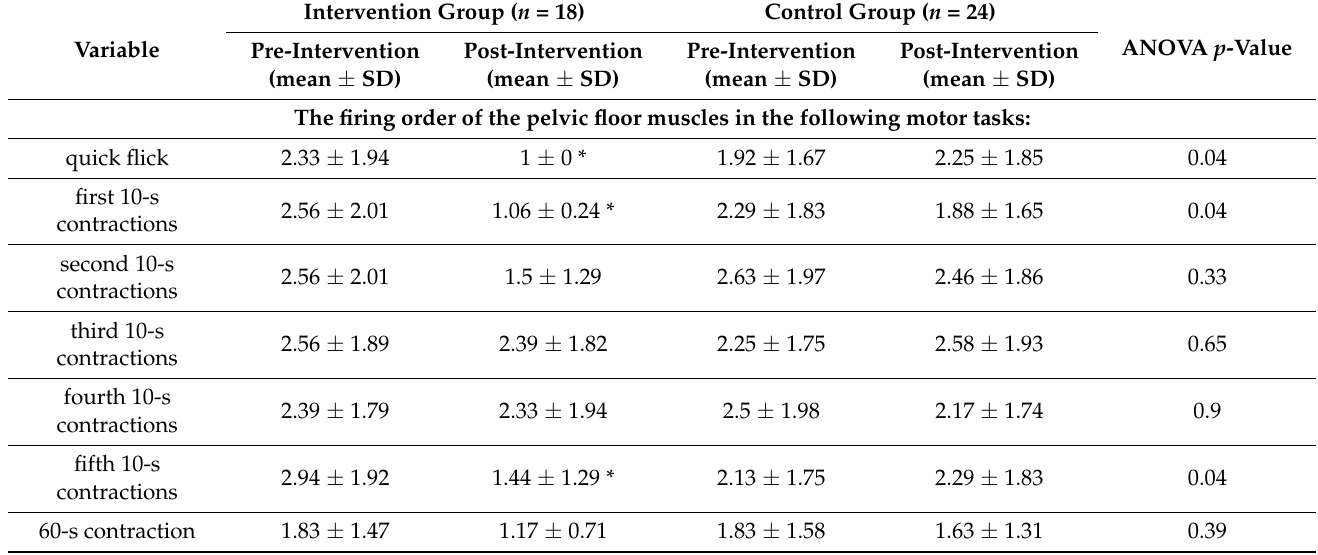
Table 2. The firing order and technique scores for pelvic-floor muscle contraction pre- and post-